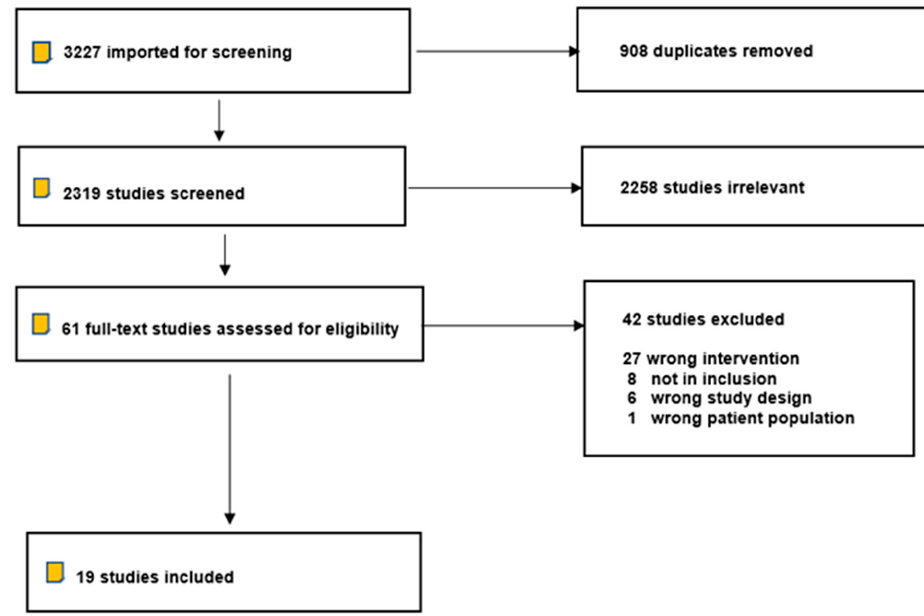
Figure 1. PRISMA flow diagram.